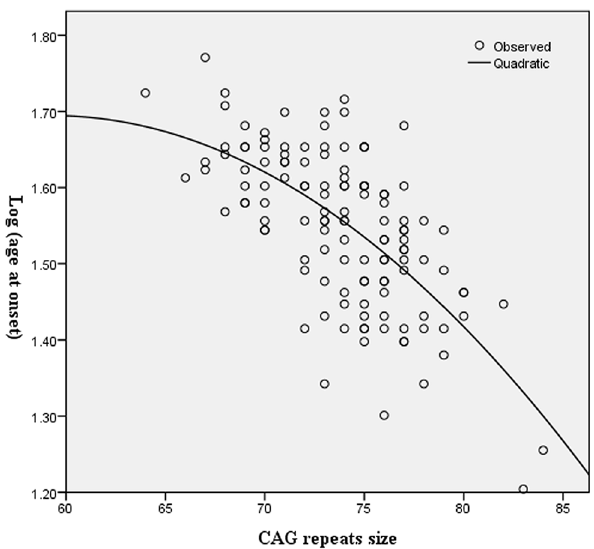
Fig 3. Modification of the age at onset due to expanded CAG repeats in ATXN3 of SCA3/MJD patients. The X-axis denotes the expanded CAG repeat lengths and the Y-axis indicates logarithmically transformed ages at onset. Model parameters: Log (age at onset) = -0.571 + 0.076 Exp — 0.001 Exp 2 . With Exp = Expanded CAG repeats in ATXN3 .